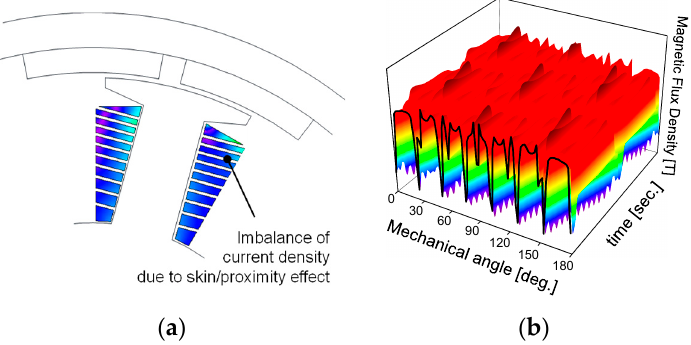
Figure 2. Causes of AC Joule loss. ( a ) Skin and proximity effect due to armature AC and ( b ) variation in slot leakage flux.